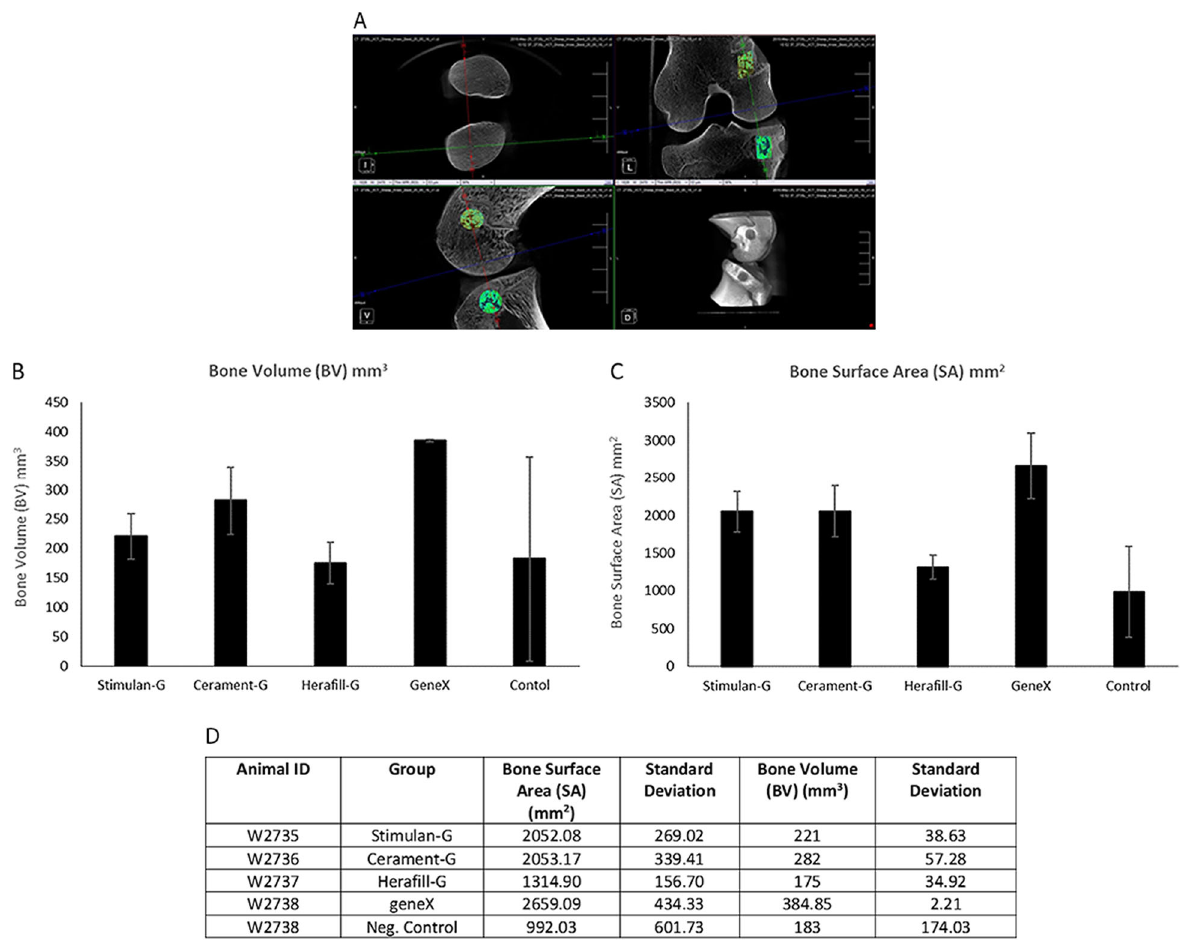
Fig. 4 a – d Mean Bone Volume (BV) and Surface Area (SA) for each group (mean ± standard deviation). One hundred and twenty- fi ve consecutive slices, in the centre of the defect were selected and assigned to a Region of Interest (ROI) shown in green. Representative image can be seen in a . Once the ROI was de fi ned, the threshold values were adjusted to isolate the newly formed bone from bone marrow. The ROI was used to determine the bone volume (BV) and